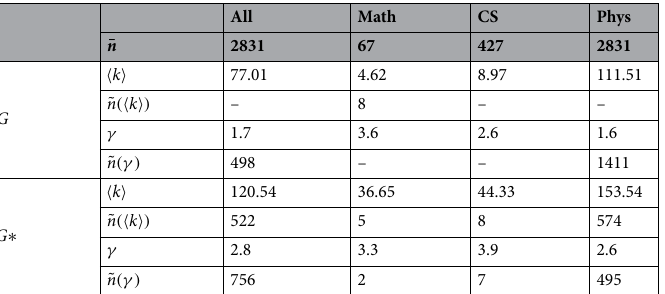
Table 2. Maturation indices and maturation values of the degree distribution’s properties for the primal and dual graphs. All notations and definitions are reported in the text. The symbol “–” reflects the fact that the property does not maturate, implying that significant changes in the property’s value occur at all fusion indices, up to the final layer (the reported values are therefore the “asymptotic” ones obtained by fusing all layers).